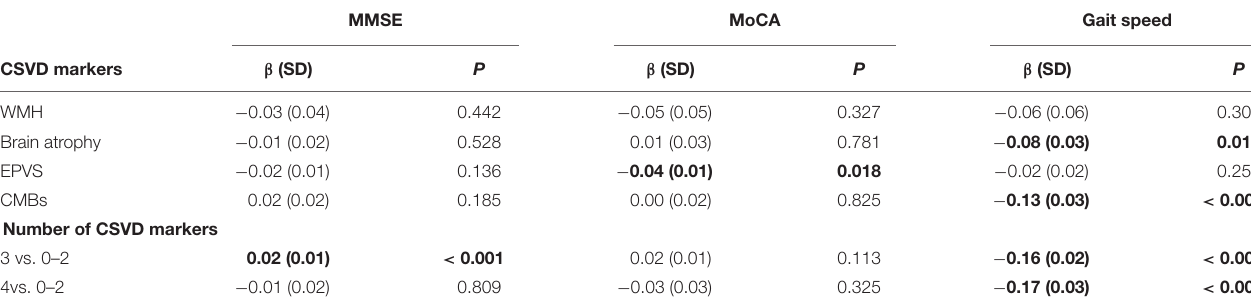
TABLE 6 | Relationship between incidental findings and cognitive function as well as gait speed. MMSE MoCA